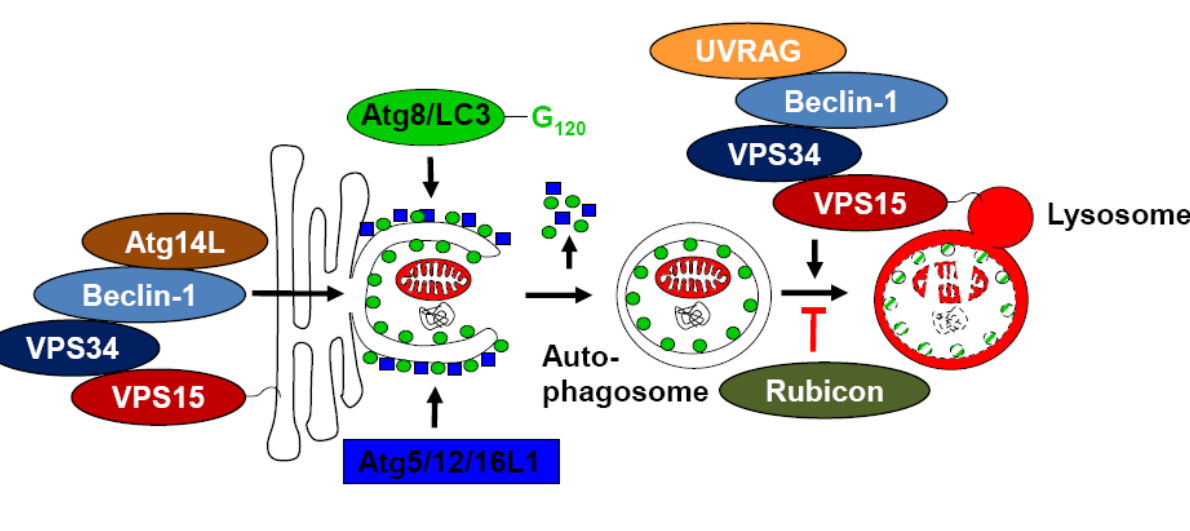
Figure 1. Atg6/Beclin-1 containing PI3 kinase complexes catalyze autophagosome generation and fusion with lysosomes. The Beclin-1 containing complex with Atg14L, VPS34 and VPS15 marks membranes at which the phagophore forms, which expands around its substrates with the help of the two ubiquitin-like molecules Atg8 and 12 and upon closure constitutes double-membrane surrounded autophagosomes. Their fusion with lysosomes is assisted by the UVRAG, VPS34 and VPS15 containing Beclin-1 complex. Recruitment of Rubicon into this complex blocks autophagosome fusion with